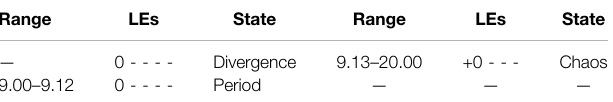
TABLE 2 | System state corresponding to different parameter c when the original conditions is (1, 1, 1, 1, 1). Range LEs